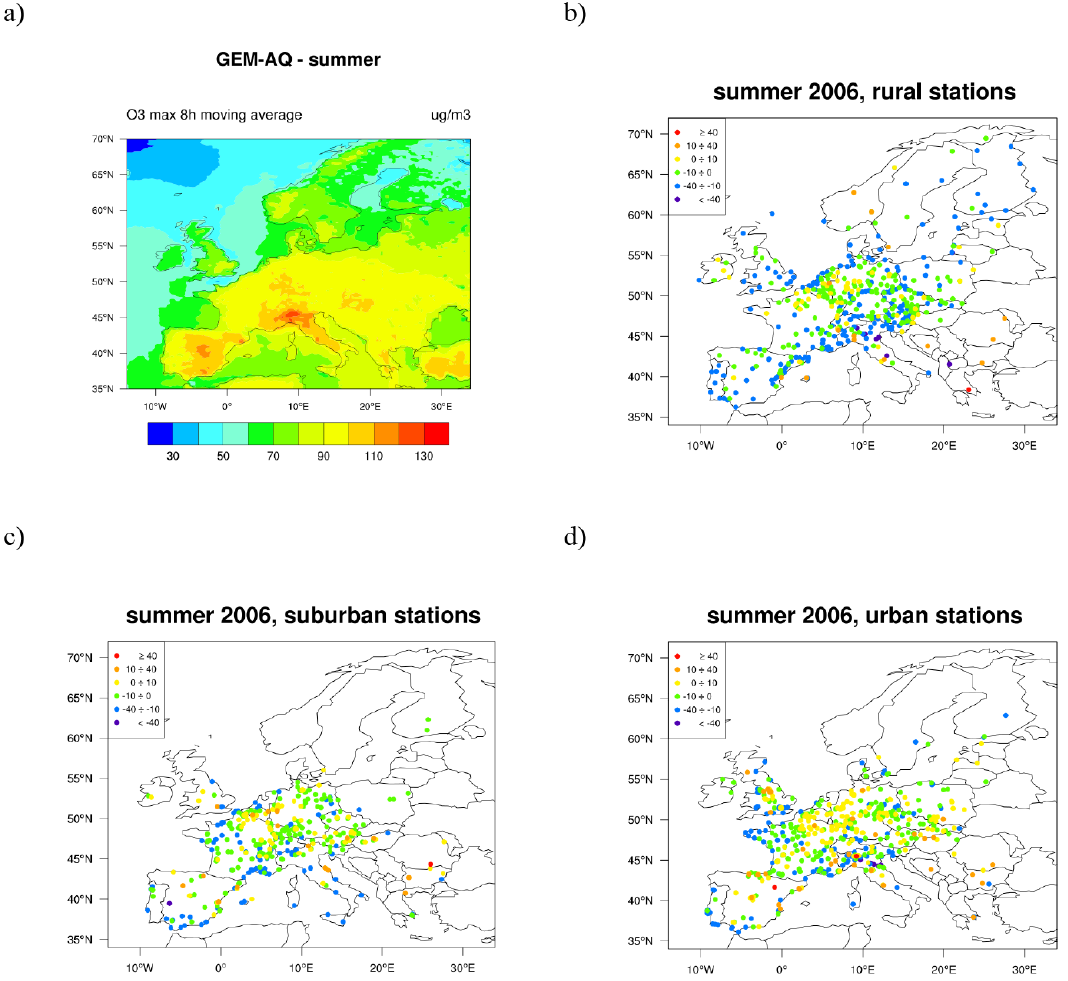
Figure 5. Summer (JJA) maximum 8h running average ozone concentration in µgm − 3 (a) , MBE at rural stations (b) , MBE at suburban stations (c) and MBE at urban stations (d)